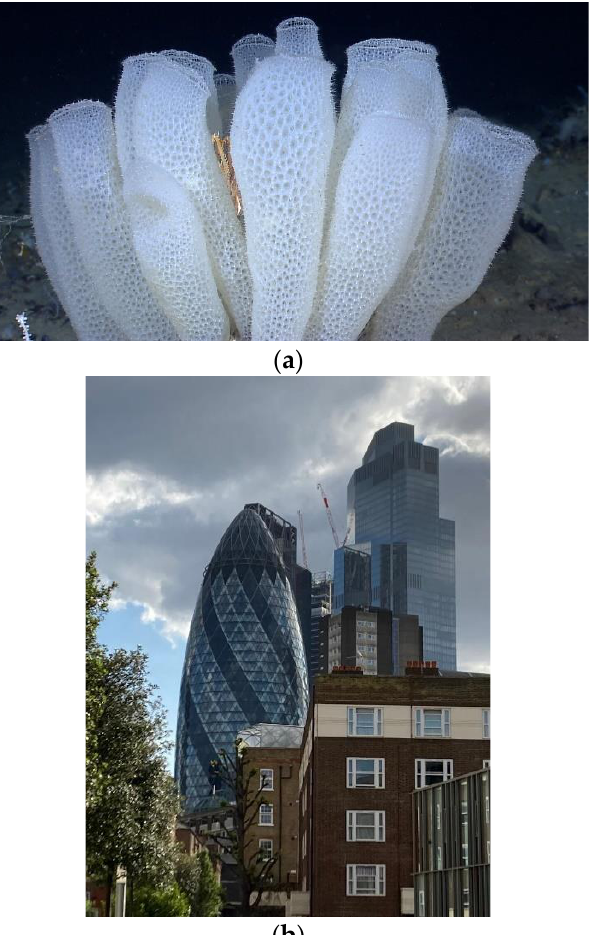
Figure 4. Swiss Re Building (Gherkin) inspired by Venus’ flower basket ( Euplectella aspergillum ): ( a ) Venus’ flower basket under the ocean; ( b ) Swiss Re Building, London. Image ( a ): Wikipedia. Im- age.